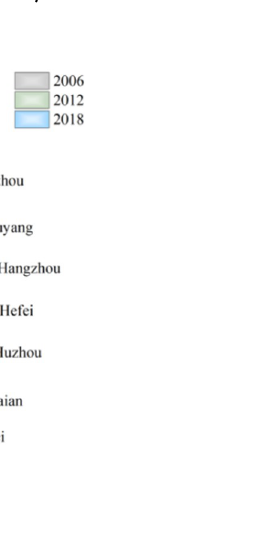
Fig 7. Technology gap rate of cities in the lower reaches.